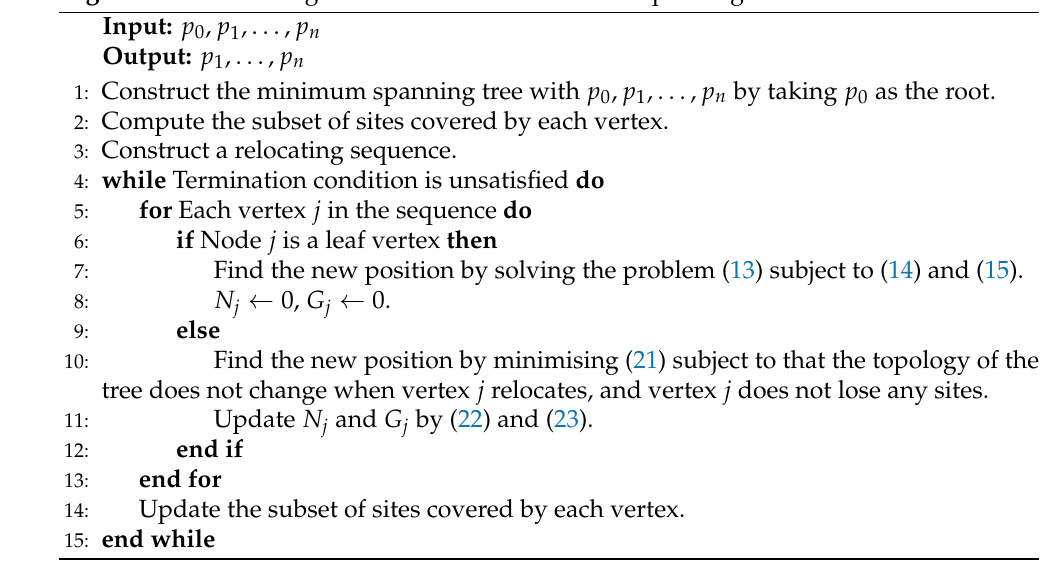
Algorithm 1 Relocating the vertices in the minimum spanning